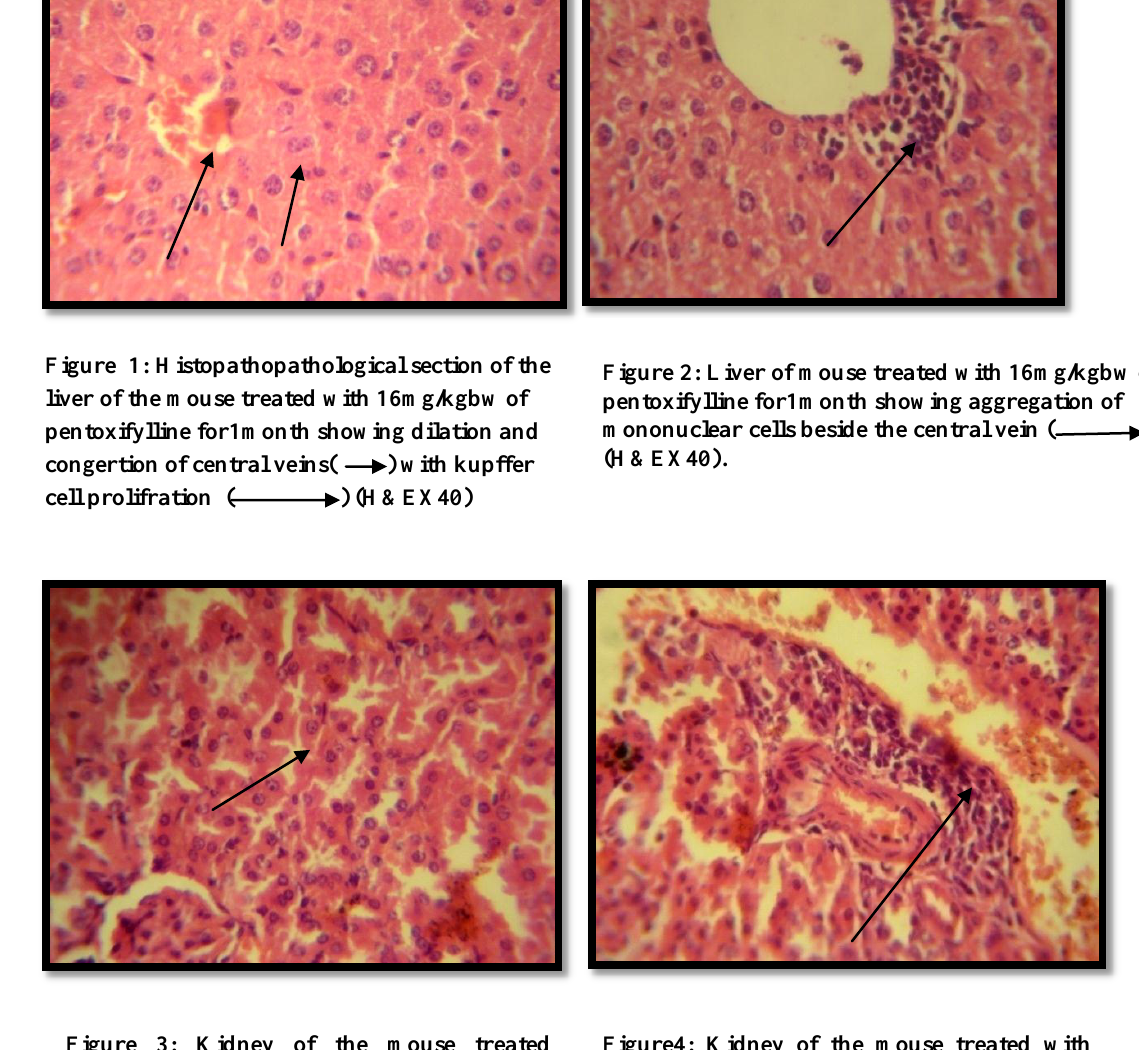
Figure4: Kidney of the mouse treated with 16mg/kgbw of pentoxifylline for 1month showing perivascular